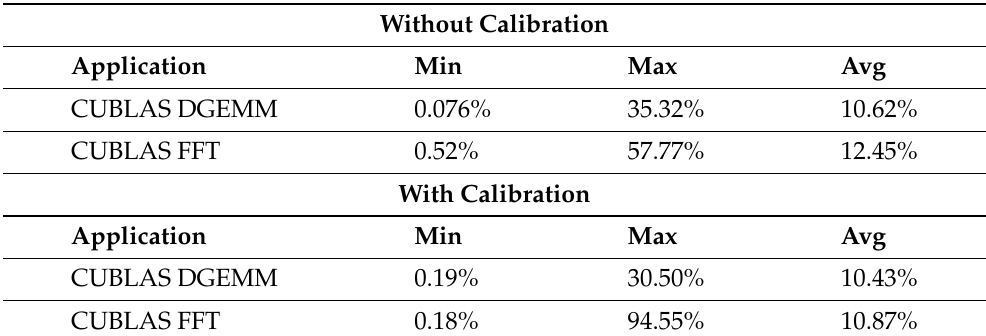
Table A3. Percentage error of dynamic energy consumption obtained using NVML against ground- truth on Nvidia K40c GPU (Figure 1) with and without calibration.